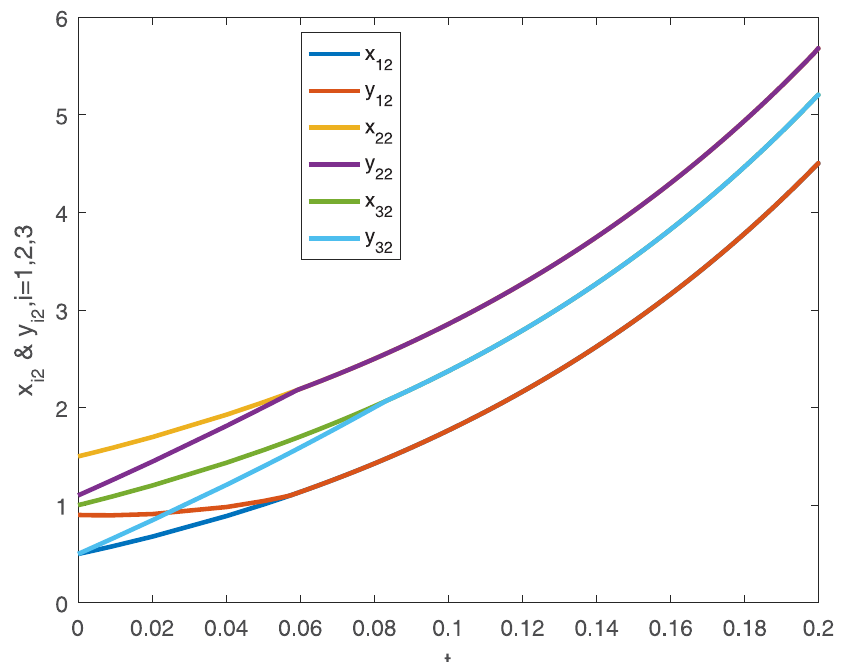
Fig 6. The second dimensional trajectories of with initial conditions x 1 ( t 0 ) = [0.5 + sin ( t ), cos ( t ) − 0.5] T , x 2 ( t 0 ) = [ sin ( t ) − 0.5, 0.5 + cos ( t )] T , x 3 ( t 0 ) = [ sin ( t ), cos ( t )] T and response system (19) with initial conditions y 1 ( t 0 ) = [0.1 + sin ( t ), cos ( t ) − 0.1] T , y 2 ( t 0 ) = [ sin ( t ) − 0.1, 0.1 + cos ( t )] T , y 3 ( t 0 ) = [0.5 + sin ( t ), cos ( t ) − 0.5] T under the controller (8).